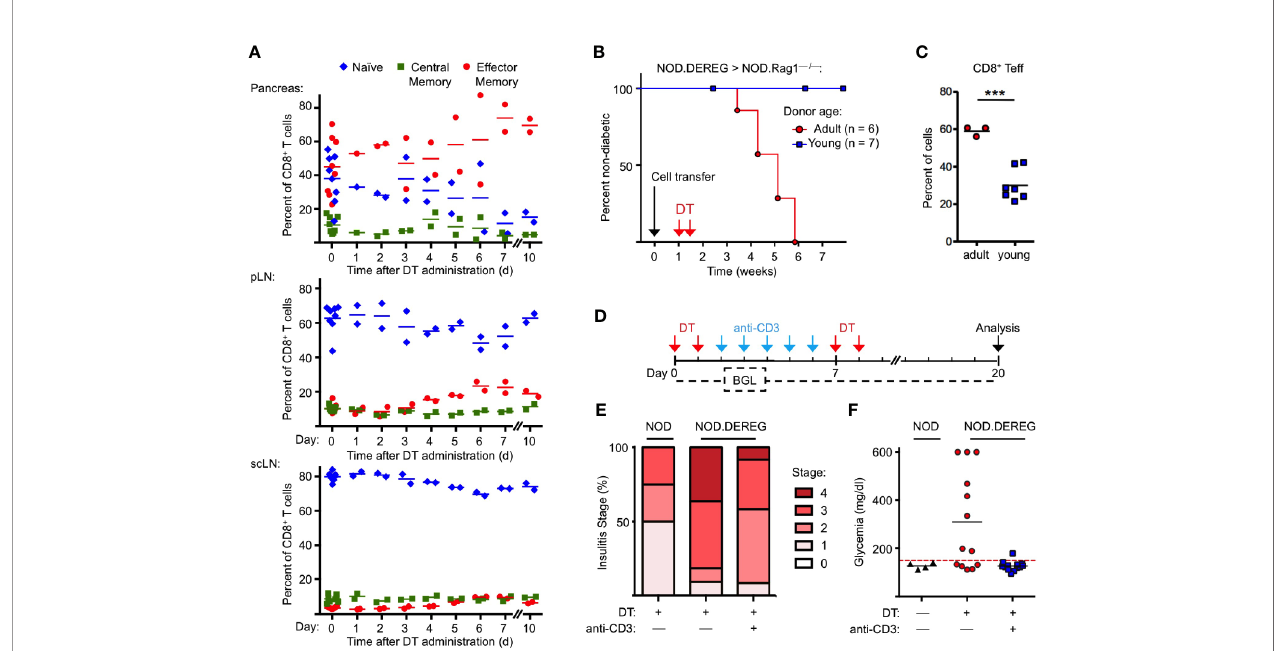
FIGURE 3 | Anti-CD3 mAb therapy after Treg cell ablation ameliorates insulitis and prevents progression to hyperglycemia. (A) Kinetics of CD8 + T cells with a naïve (CD62L high CD44 low ), central memory (CD62L int CD44 int ), and effector/memory (CD62L low CD44 high ) phenotype in pancreas (top), pLN (middle), and scLN (bottom) of 10-12-week-old NOD.DEREG mice before (day 0) and at indicated days after DT administration. (B, C) Adoptive splenocyte transfer model. (B) Splenocytes from adult (16-18-week-old) but not young (4-5-week-old) DTR/GFP + NOD.DEREG donors promote overt diabetes in NOD.RAG1 – / – recipient mice after DT treatment. Black arrow indicates the day of splenocyte transfer (2 x 10 6 total cells), and red arrows indicate the days of DT administration. (Log-Rank (Mantel-Cox) test, p = 0.0097). (C) Proportions of CD8 + T cells with a CD62L low CD44 high effector/memory phenotype in the pLN of NOD.RAG1 – / – recipients of splenocytes from young (red circles) or adult (blue squares) NOD.DEREG donors. Unpaired t-test: ***p < 0.001. (D – F) anti-CD3 mAb treatment of Treg cell-depleted NOD.DEREG mice. (D) Scheme of experimental design. Cohorts of adult NOD.DEREG females were injected with DT only (n = 13), or were additionally treated with anti-CD3 mAb (n = 13). Untreated DTR/GFP – NOD.DEREG mice were included for comparison (n = 4). Arrows: red, DT injection; blue, anti-CD3 injection; black, analysis by histology and fl ow cytometry. Blood glucose concentrations were assessed before (day 0) and every second day after the fi rst injection with DT until the end of the observation period on day 14. (E) Histological insulitis score of indicated experimental groups, and (F) blood glucose levels of individual mice (one-way ANOVA: p ≤ 0.01). Each symbol in (A, C, F) corresponds to an individual